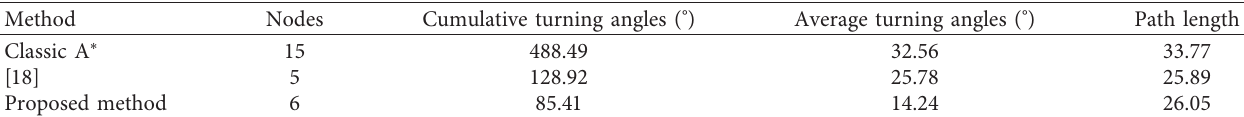
Figure 3: Path planning results. (a) The path trajectory generated by the traditional A ∗ algorithm. (b) The path trajectory generated with [18]. (c) The path trajectory generated by the proposed method. Table 2: Planned paths with different